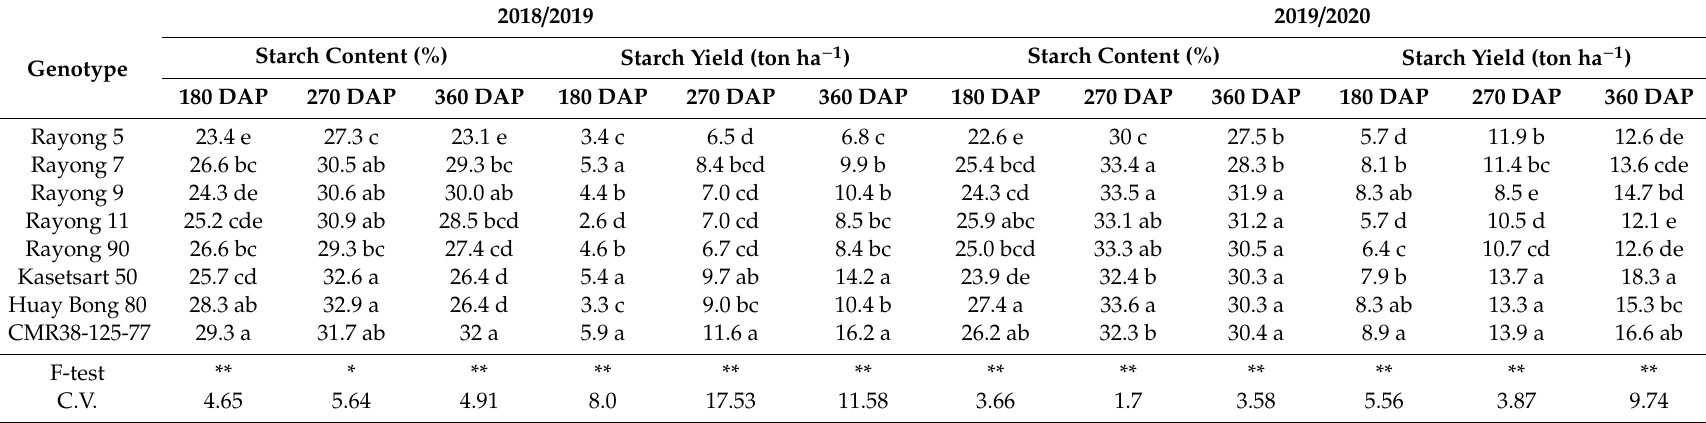
Table 2. Starch content and starch yield at di ff erent days after planting (DAP) for eight cassava genotypes grown in 2018 / 2019 and 2019 /